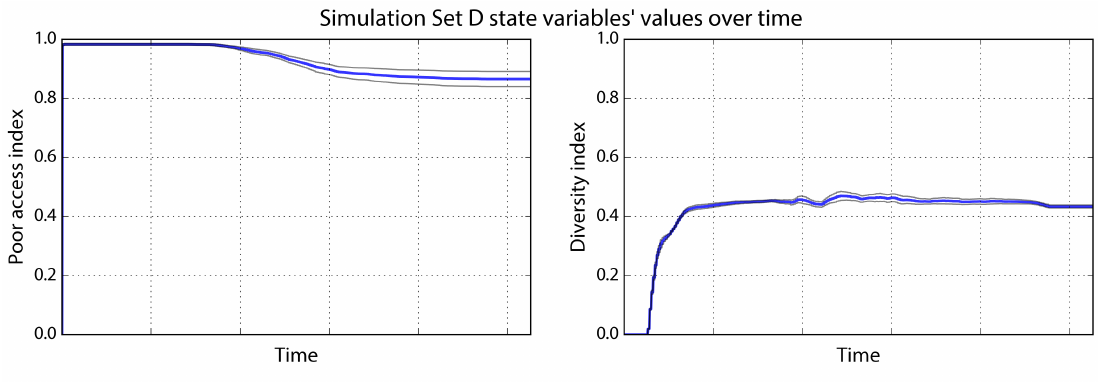
Figure 8. Set D’s state variables from initialization through the end of the simulation, with mean value (blue) and 95% confidence interval (gray) across 50